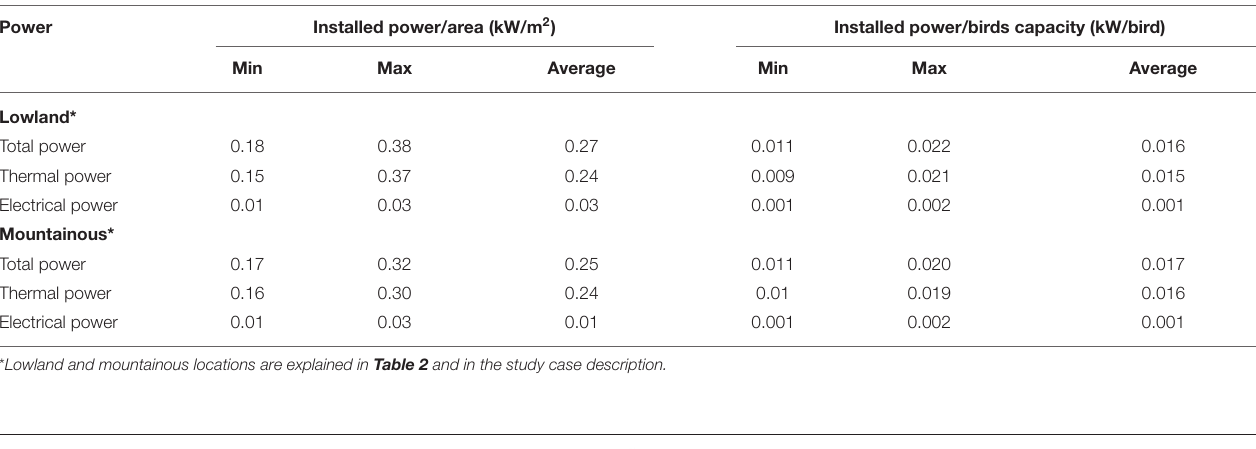
TABLE 3 | Installed power in the broiler facilities examined.